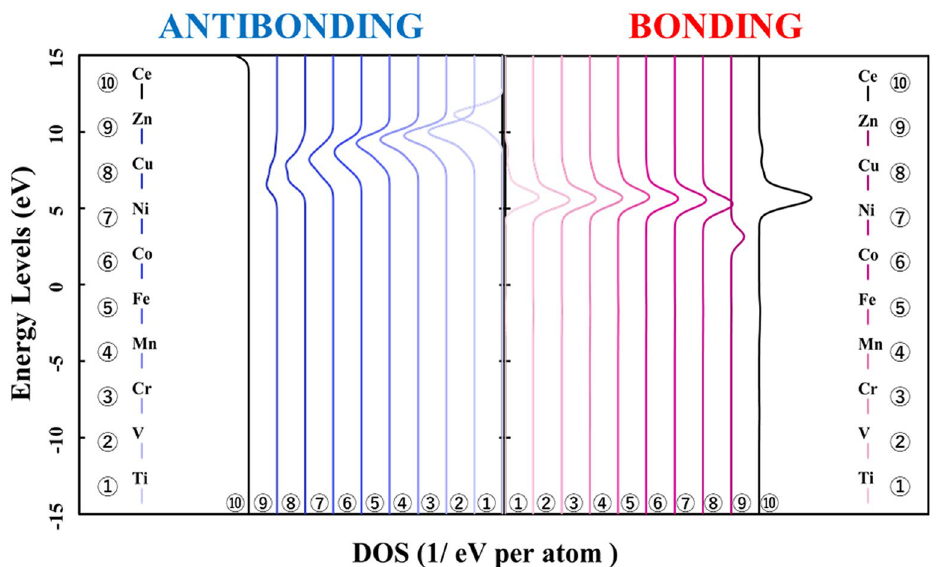
Figure 8. Energy levels of the bond composition between the metal 3d orbitals and the oxygen 2p orbitals are based on the reference level as the vacuum level in the M@Ce 12 O 836+ cluster model (M = Ti, V, Cr, Mn, Fe, Co, Ni, Cu, Zn, Ce). The bond composition between the metal 5d orbitals and the oxygen 2p orbitals are in the undoped ceria. The bonding and antibonding orbital components are on the right and left sides,